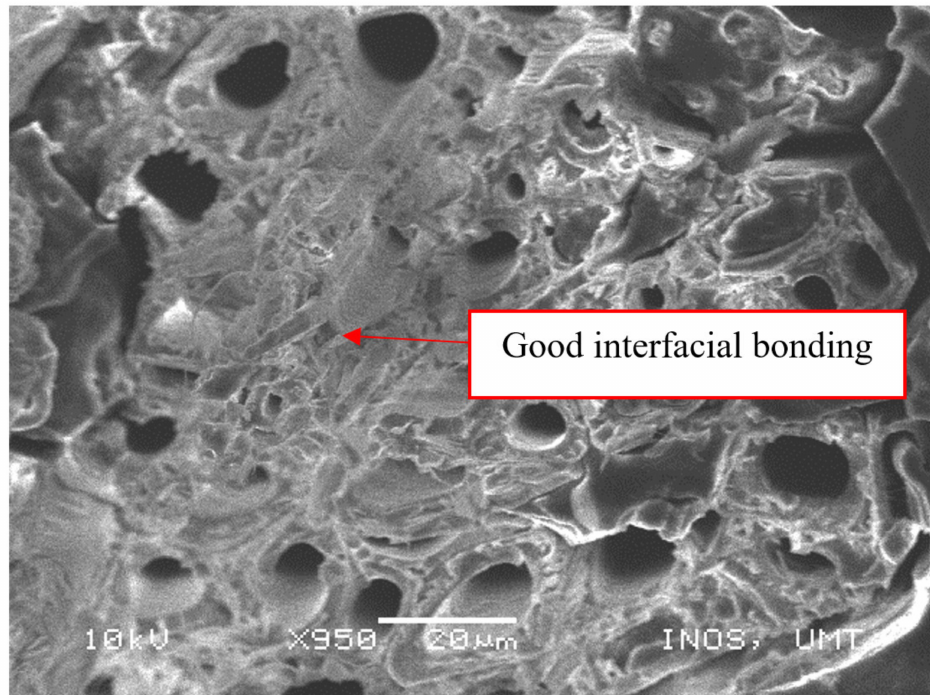
Figure 10. Good interfacial bonding in the epoxy/PET/KF-20 sample.